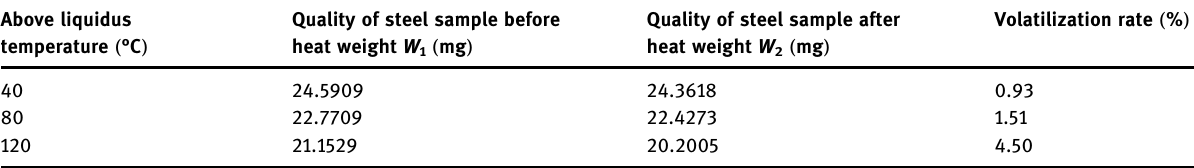
Quality of steel sample